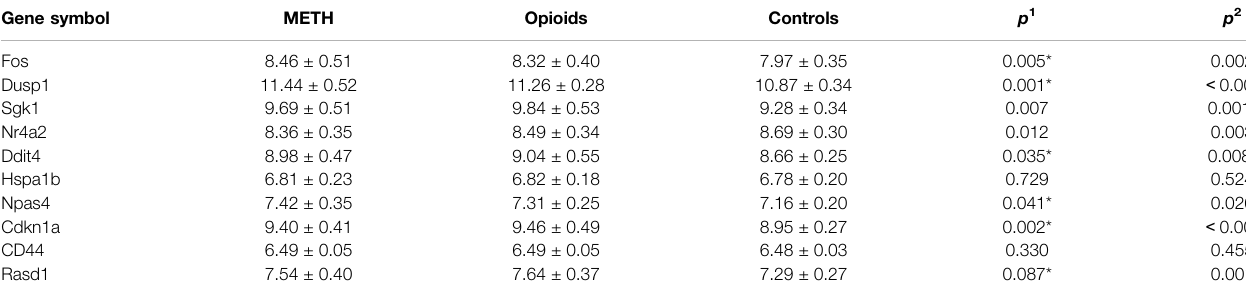
TABLE 5 | The relative mRNA levels of hub genes in GSE15774 database (mean ± SD). Gene symbol